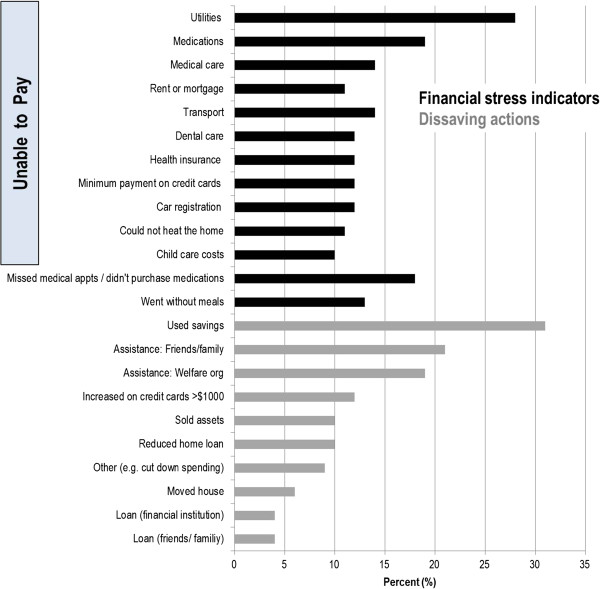
Proportion of participants reporting each indicator of hardship.